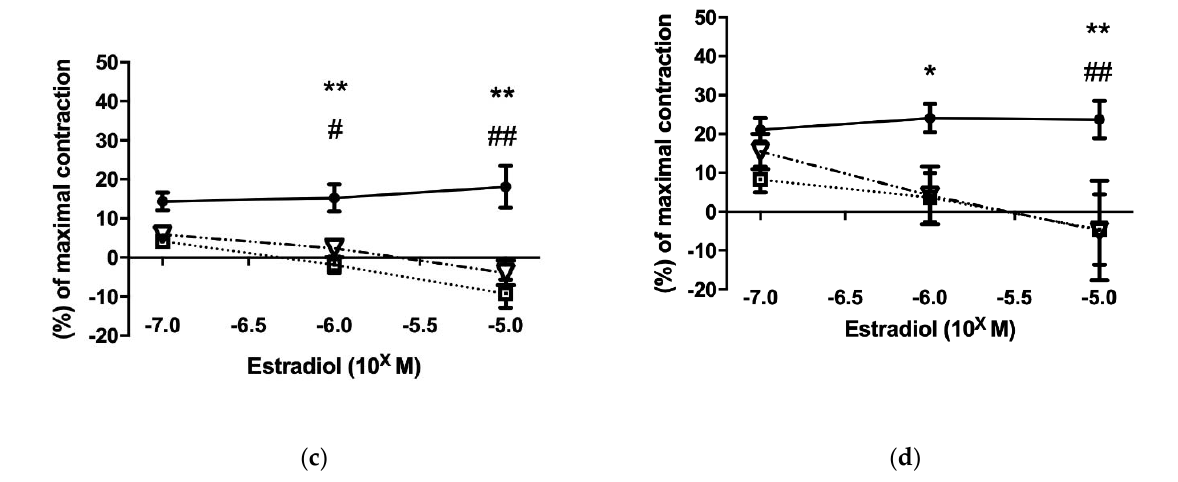
Figure 2. Estradiol-induced vasorelaxation in the presence of eNOS (L-NAME) or COX-2 (NS398) inhibitors. Panel ( a ): T-D+ group. Panel ( b ): T+D+. Panel ( c ): T-D-. Panel ( d ): T+D-. After L-NAME incubation, estradiol dependent vasorelaxation significantly decreased in each group. After incubation with COX-2 inhibitor, vasorelaxation decreased only in the vitamin D deficient groups but testosterone treatment did not influence it. Data are presented as mean ± SEM. Repeated measures two-way ANOVA using Bonferroni’s post hoc test: *: p < 0.05 L-NAME vs. without inhibition, **: p < 0.01 L-NAME vs. without inhibition, ł: p < 0.05 L-NAME vs. COX-2 inhibitor, #: p < 0.05 COX-2 inhibitor vs. without inhibition, ##: p < 0.01 COX-2 inhibitor vs. without inhibition.